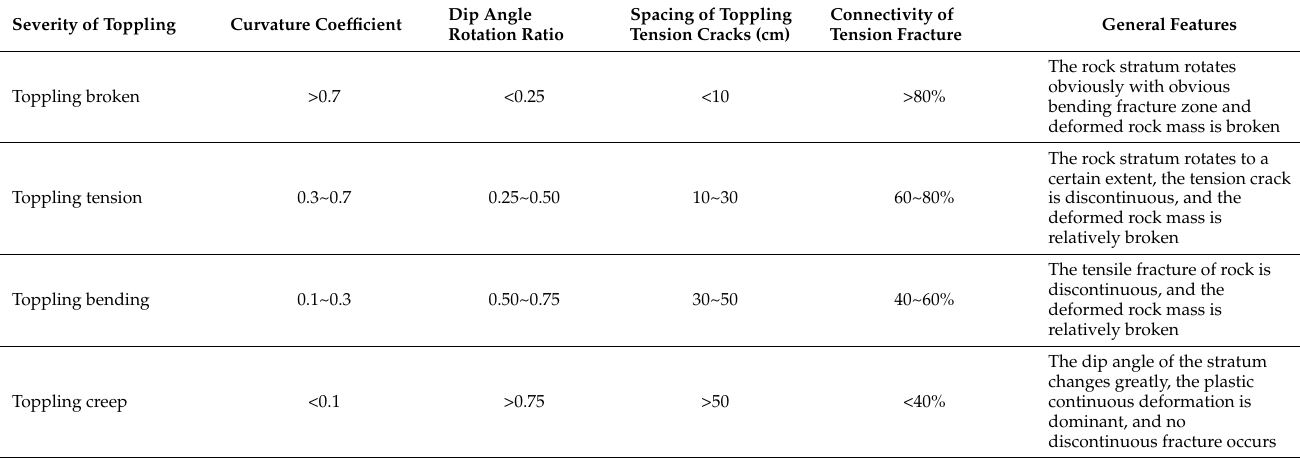
Table 3. Classification of the rock toppling deformation